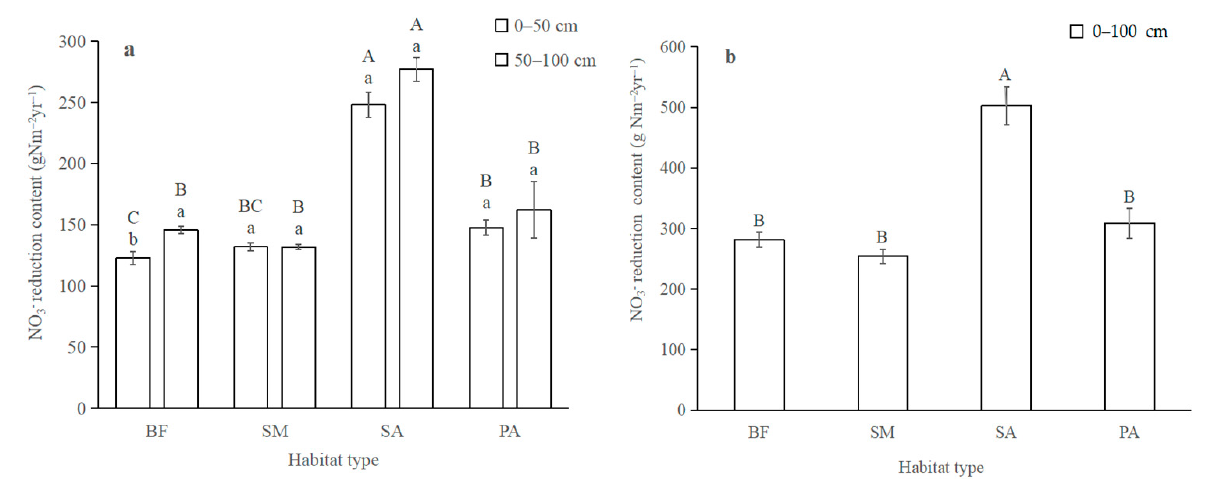
Figure 4. NO 3 − retention content between four habitat types: ( a ) in the upper 50 cm and deeper 50 cm, ( b ) at the 0–100 cm depth. Error bars in the column represent standard errors. SM: S. mariqueter ; SA: S. alterniflora ; PA: P. australis ; BF: bare mudflat. Bars with different uppercase letters and lowercase letters denote significantly different in habitat types and soil depths, respectively ( p < 0.05).